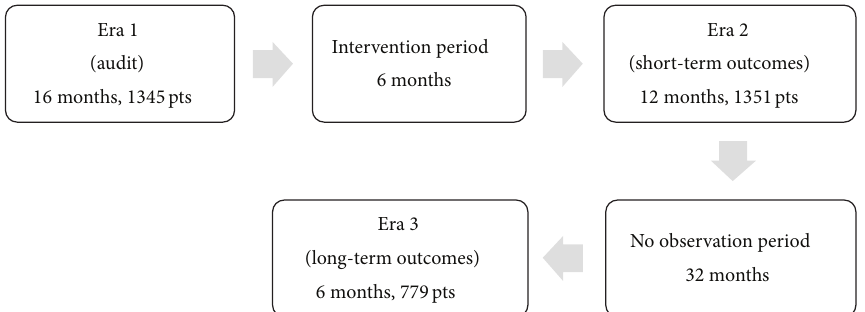
Figure 1: Flow diagram of the study: Eras 1, 2, and 3 of the study are separated by the intervention and nonobservation periods, respectively.